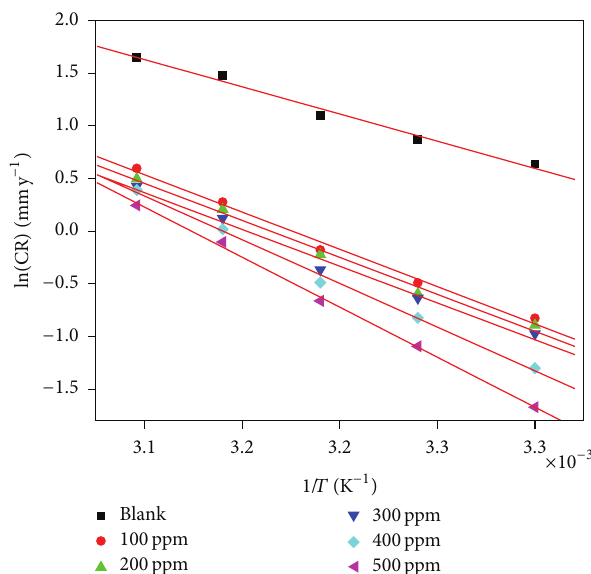
Figure 7: Arrhenius plots for the corrosion of aluminum in 0.5 M phosphoric acid containing different concentrations of inhibitor (GIE).